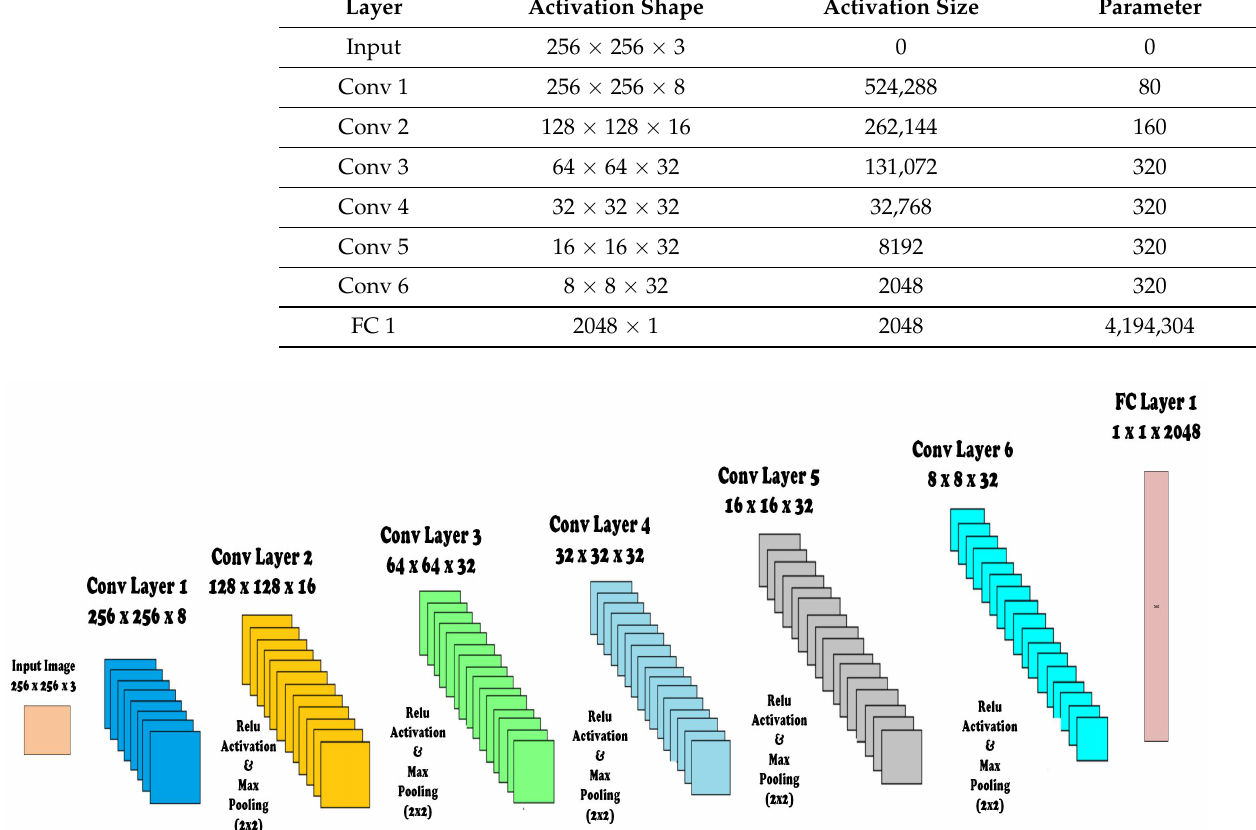
Figure 4. Custom design lightweight CNN